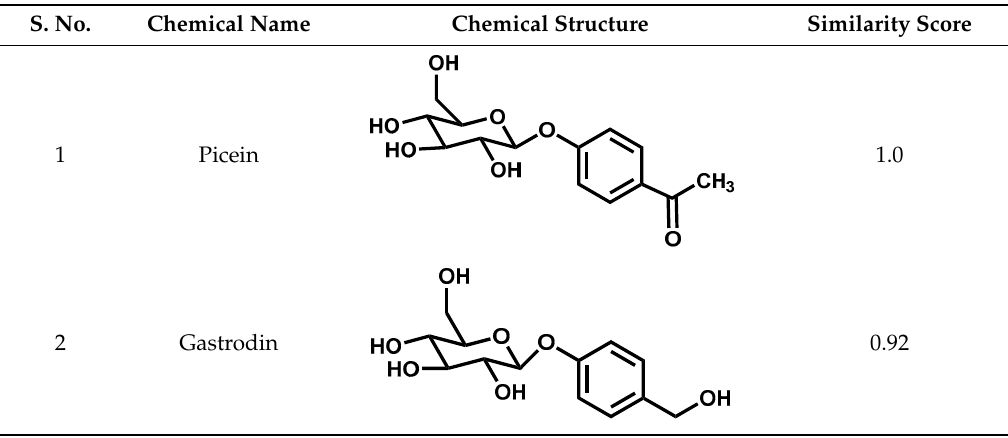
Table 1. SIMCOMP (SIMilar COMPound) similarity score of picein and gastrodin.